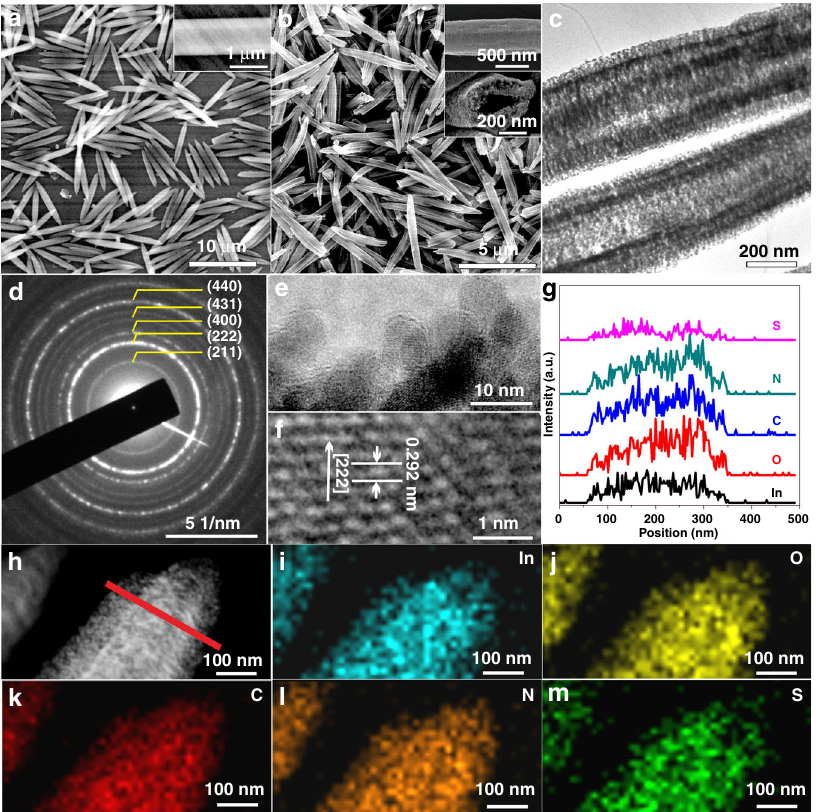
Fig. 2 Morphology and structural characterizations. a SEM image of N,S-codoped MIL-68-In. b SEM images, c TEM image, d Corresponding SAED pattern, e Local enlarged TEM image, f HRTEM image, g Elemental pro fi les, h STEM image, and i – m EDX elemental mapping of In, O, C, N, and S for N,S-C/In 2 O 3 DHR. Source data are provided as a Source Data fi